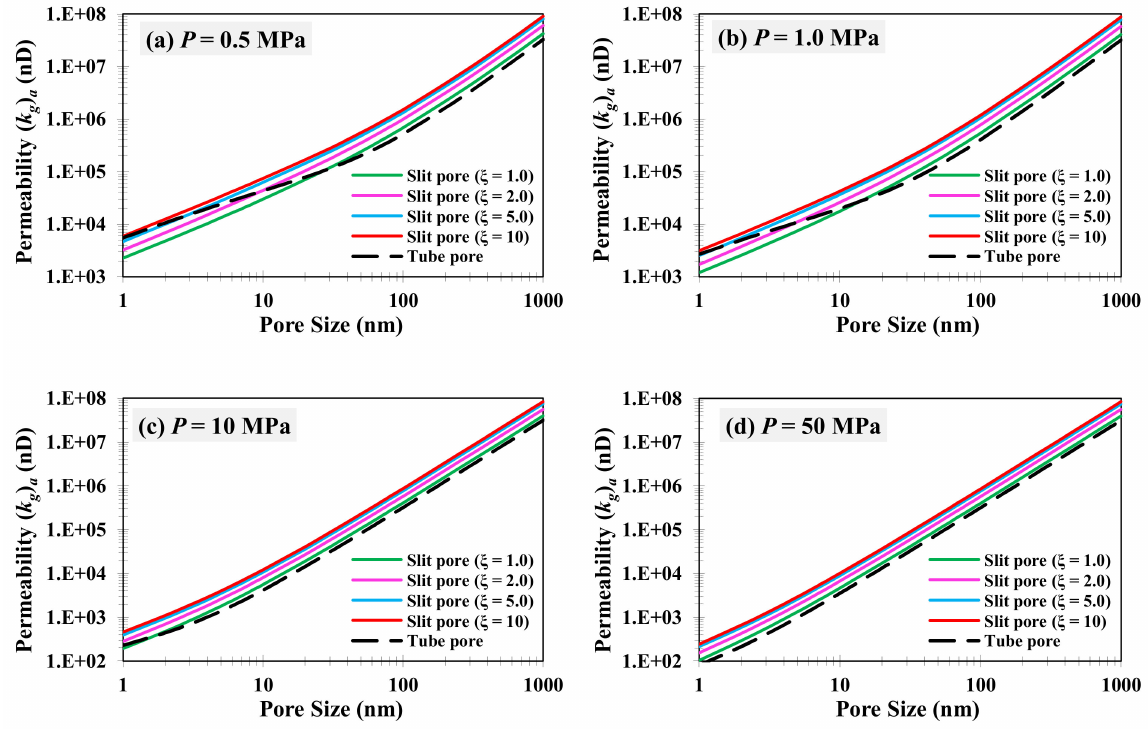
Figure 6. Comparison of permeability between slit and circular pores with the same